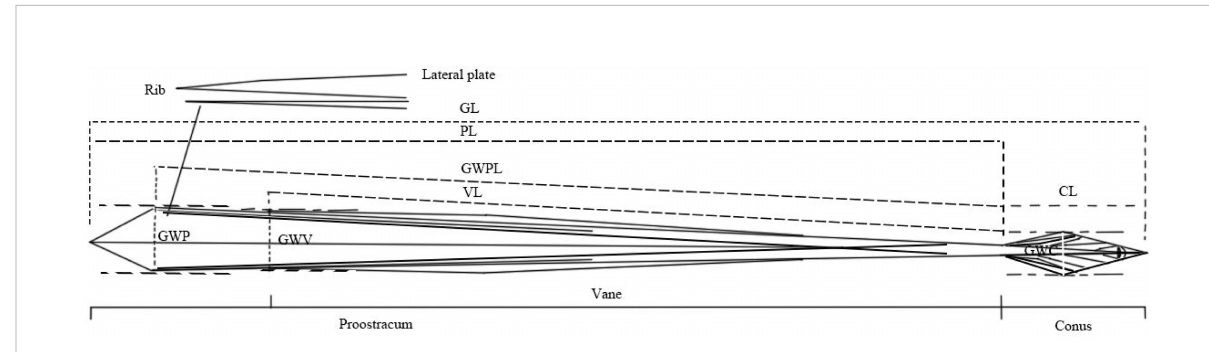
FIGURE 2 Scheme of gladius morphometric measurements for Sthenoteuthis oualaniensis . GL, total gladius length; CL, length of the cone; GWC, greatest width of the cone; PL, proostracum length; VL, length of the vane; GWV, greatest width of the vane; GWPL, length of the greatest width of the proostracum; GWP, greatest width of the